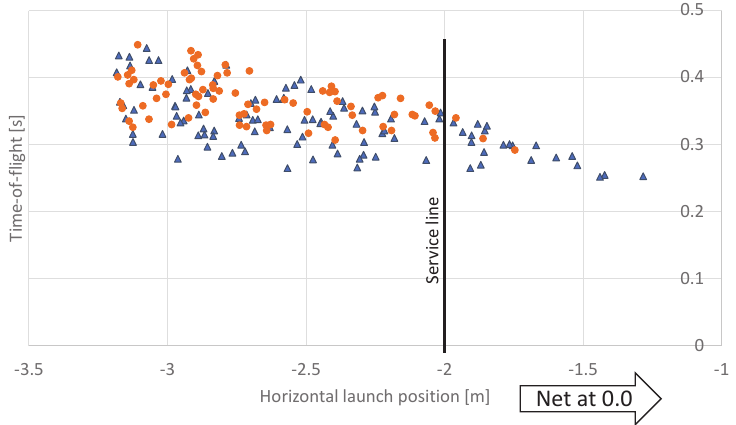
Figure 6. The time-of-flight of the excellent serves plotted against launch position. Triangles: old serve height. Circles: new serve